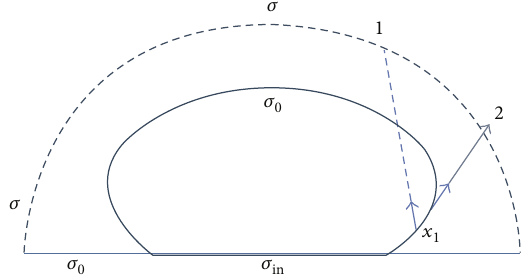
Figure 1: The cartoon of the particlization at the hypersurface 𝜎 0 (solid line) and spectra formation at 𝜎 (dashed line). The very initial system forms at the hypersurface 𝜎 𝑖𝑛 (double line) and then evolves. The Gauss theorem in (10) and (11) is applied to enclosed hypersurface 𝜎 0 ⊕ 𝜎 . In the case of large opacity 𝑓 𝜎 particle 1 , also is small for particle 2 , and so 𝑝 𝜇 Δ𝜎 0 , while for the distribution function 𝑓(𝑥 Δ𝜎 𝜇 (𝑥 )𝑓(𝑥 ,𝑝) is not zero, and for 𝑝 = 𝑝 𝑝 𝜇 1 1 0 is a nonspace-like site of the hypersurface 𝜎 0